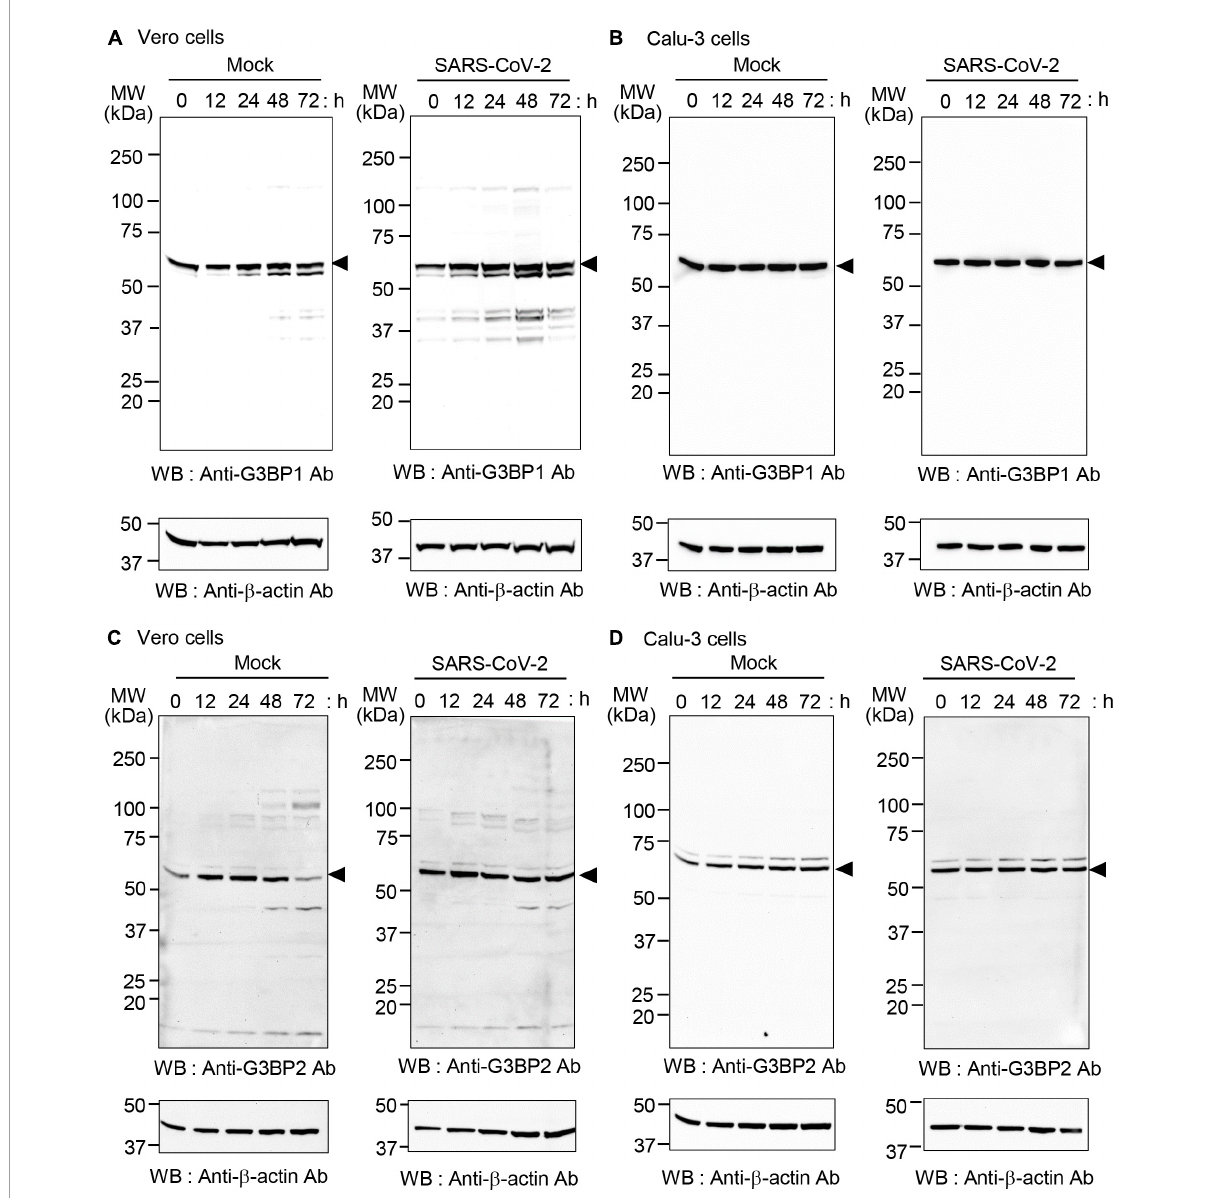
FIGURE3 Expression of G3BP1 and G3BP2 in SARS-CoV-2-infected Vero and Calu-3 cells. Vero cells (A,C) and Calu-3 cells (B,D) were mock-infected (left) or infected with SARS-CoV-2 S clade at 0.1 MOI (right) for the indicated times. Cell lysates were prepared and analyzed by western blot with anti-G3BP1 antibody (A,B) or anti-G3BP2 antibody (C,D) . In all cases, anti- β -actin was used as the input control (shown at bottom in all